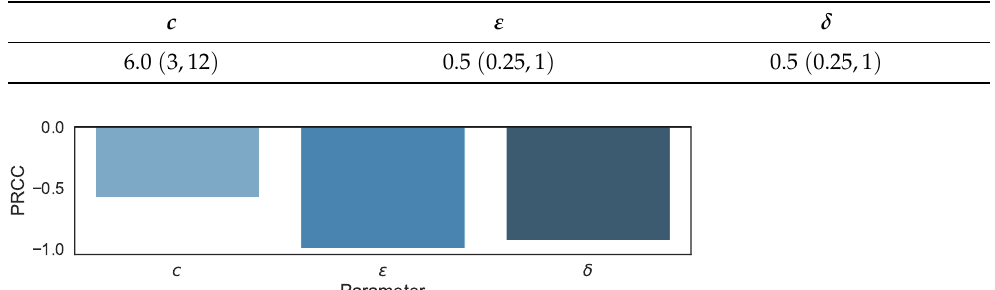
Table 1. Central values of the biphasic model for the PRCC. The (min, max) of the parameter space are shown.